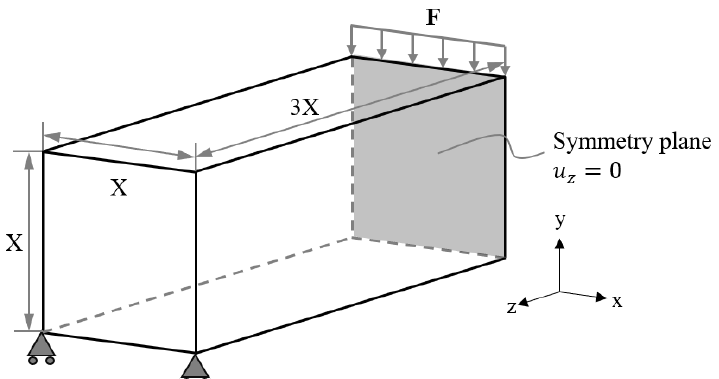
Figure 17. Dimensions and boundary conditions sketch of the MBB beam (half model with the sym- metric boundary condition applied) bending case study. symmetric boundary condition applied) bending case